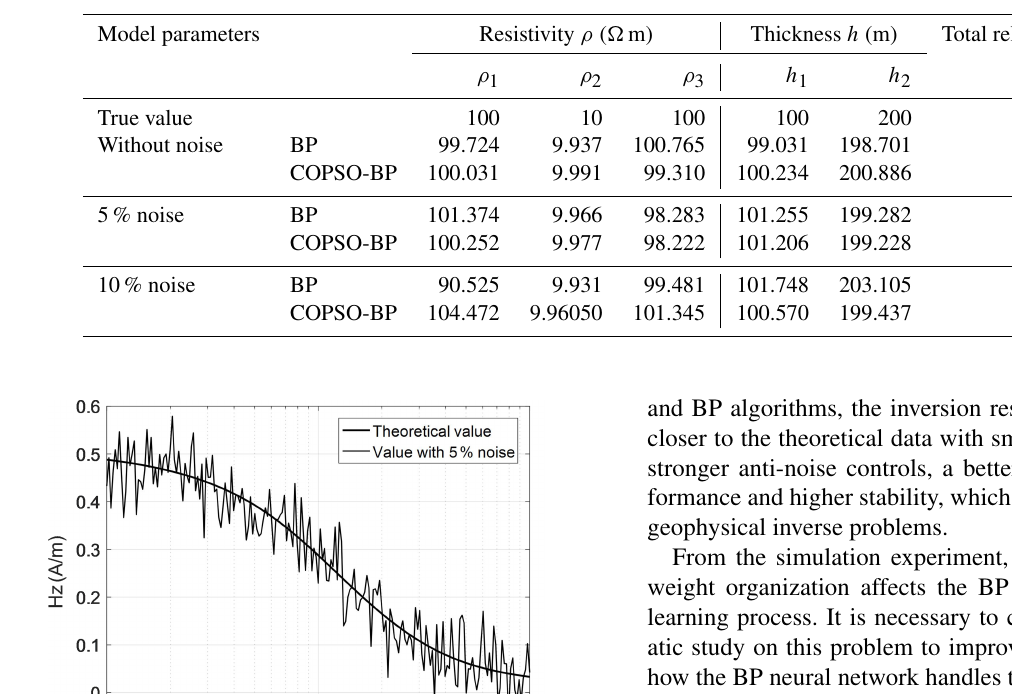
Figure 11. Inversion comparison of different geoelectric models. Table 6. Comparison of inversion results of three-layer H-type (with noise) models.